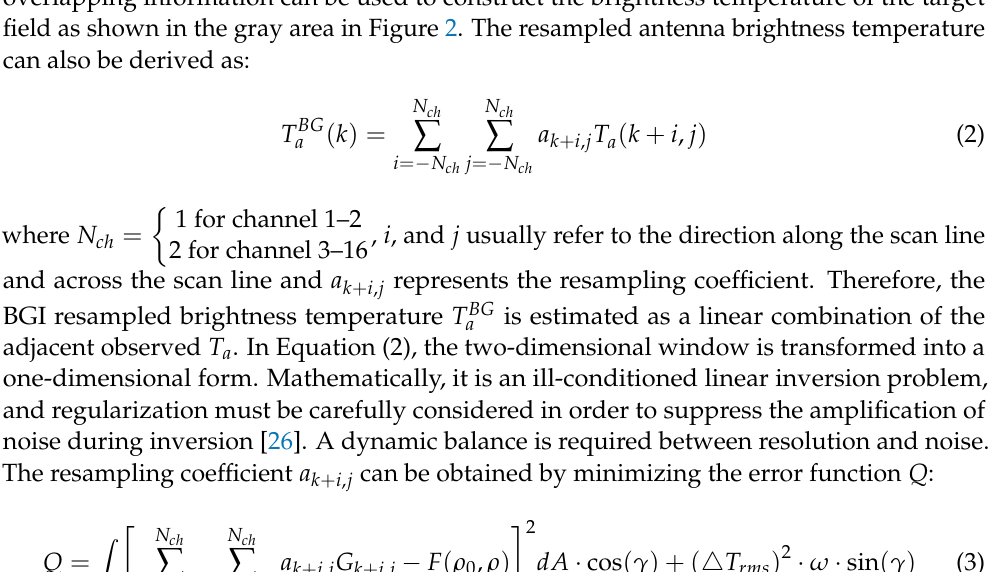
Figure 1. Schematic diagram of ATMS scan geometry. For each scan, there are a total of 96 overlapping field-of-view positions which can be used for resampling. Using the 3 × 3 or 5 × 5 FOVs in both cross-track and along-track directions, the overlapping information can be used to construct the brightness temperature of the target field as shown in the gray area in Figure 2. The resampled antenna brightness temperature can also be derived as: